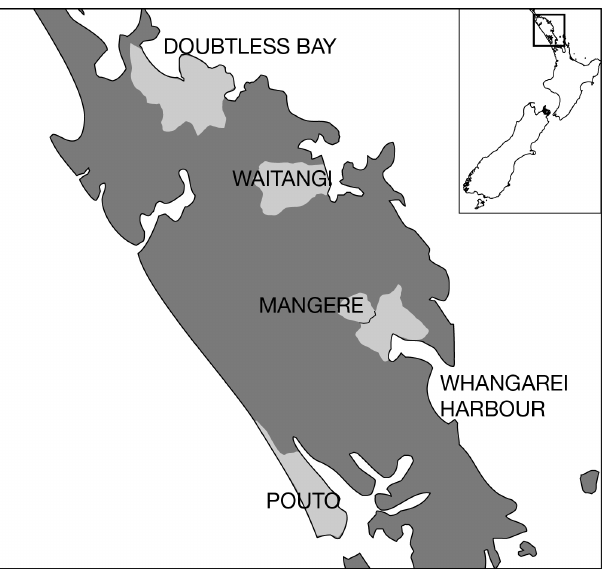
Fig. 2 . Map showing location of collaborative catchment groups, Northland, New